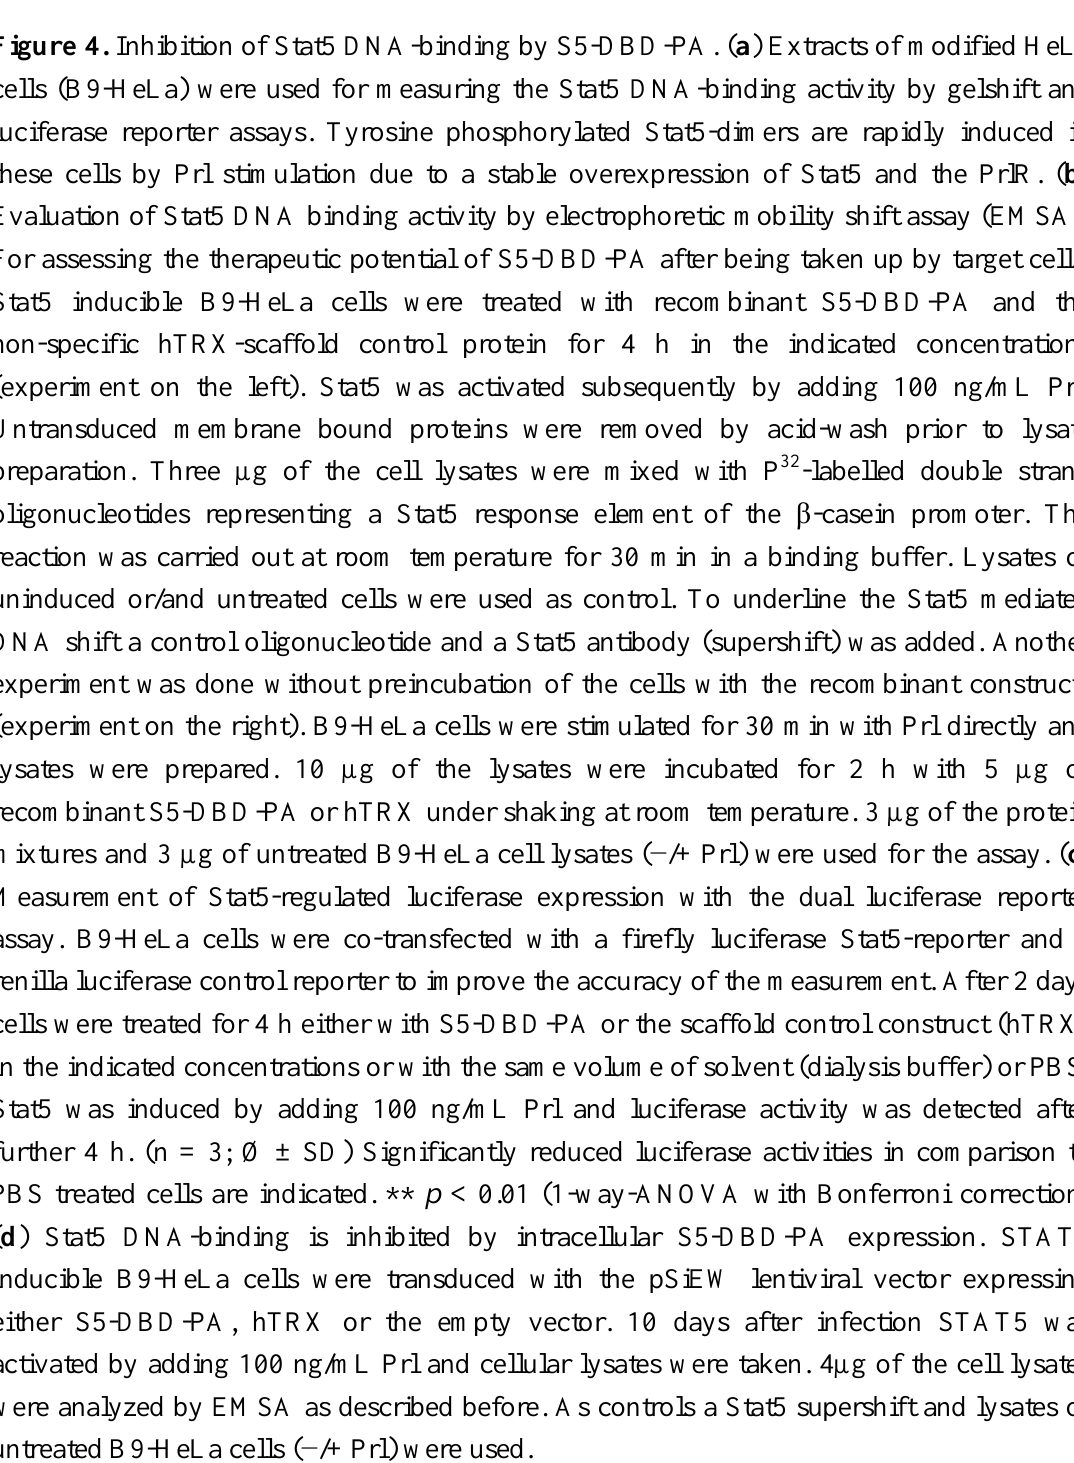
Figure 4. Inhibition of Stat5 DNA-binding by S5-DBD-PA. ( a ) Extracts of modified HeLa cells (B9-HeLa) were used for measuring the Stat5 DNA-binding activity by gelshift and luciferase reporter assays. Tyrosine phosphorylated Stat5-dimers are rapidly induced in these cells by Prl stimulation due to a stable overexpression of Stat5 and the PrlR. ( b ) Evaluation of Stat5 DNA binding activity by electrophoretic mobility shift assay